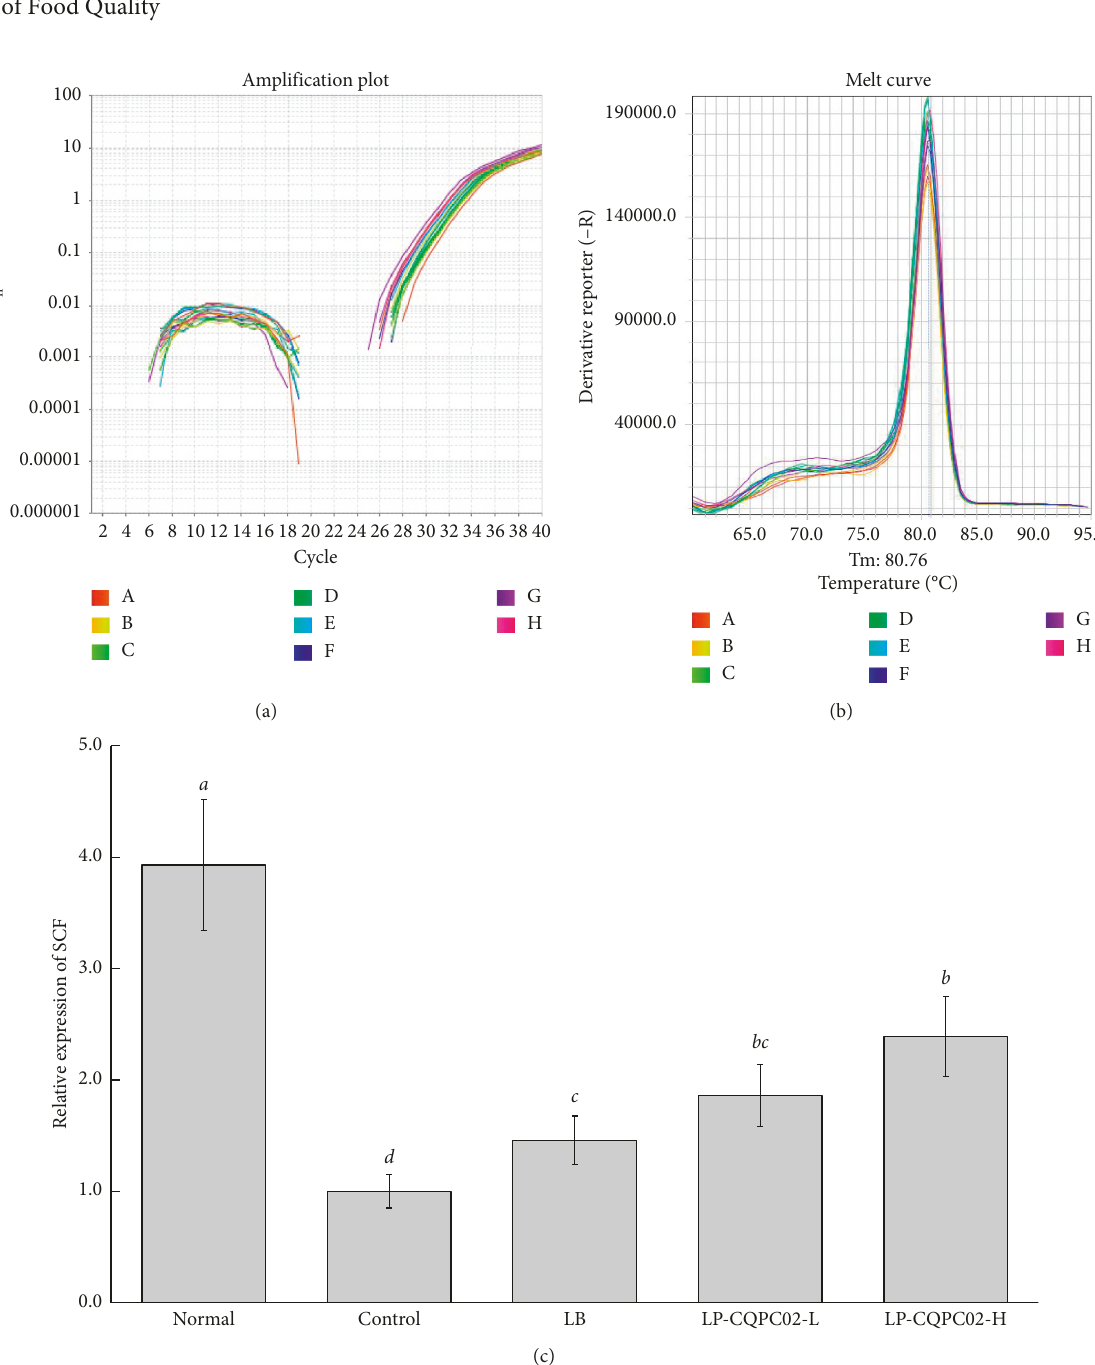
Figure 5: The mRNA expression level of SCF in the small intestine tissue of mice. (a) Amplification curve, (b) dissolution curve, and (c) relative expression. Values presented are the mean ± standard deviation. a–d The mean values with different letters in the same bars are significantly different ( p < 0.05) according to Duncan’s multiple-range test; there was no significant difference in the same letter repre- sentation between the two bars ( p > 0.05), but there was significant difference in the different letter representation ( p < 0.05). LB: Lactobacillus delbrueckii subsp. bulgaricus (1.0 × 10 9 CFU/kg b.w. gavage); LP-CQPC02-L: Lactobacillus plantarum CQPC02 (1.0 × 10 8 CFU/kg b.w. gavage); and LP-CQPC02-H: Lactobacillus plantarum CQPC02 (1.0 × 10 9 CFU/kg b.w.